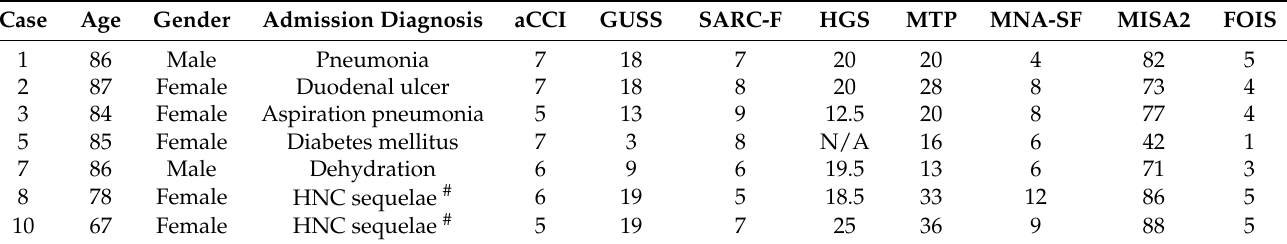
Table 1. Baseline demographic and clinical